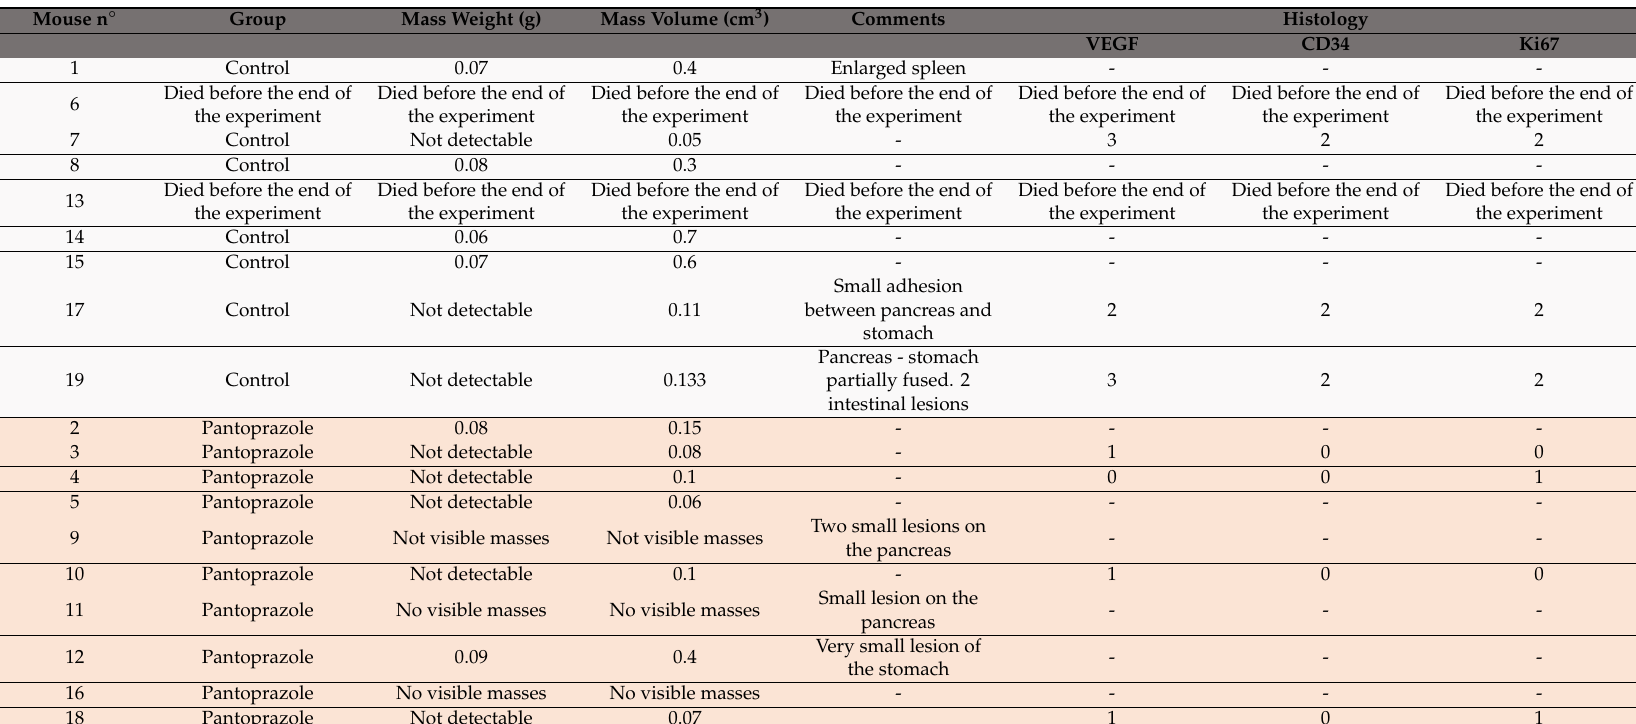
Table 1. Characteristics of pancreas tumor masses and